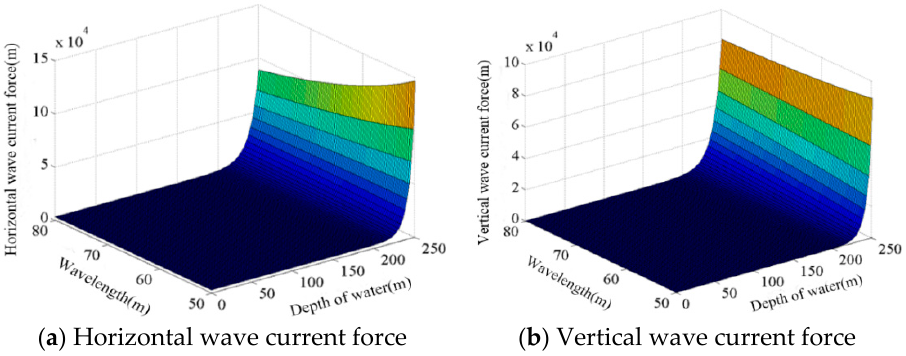
Figure 10. Variation of clamp wave flow force on horizontal steel tube with wavelength and water depth.